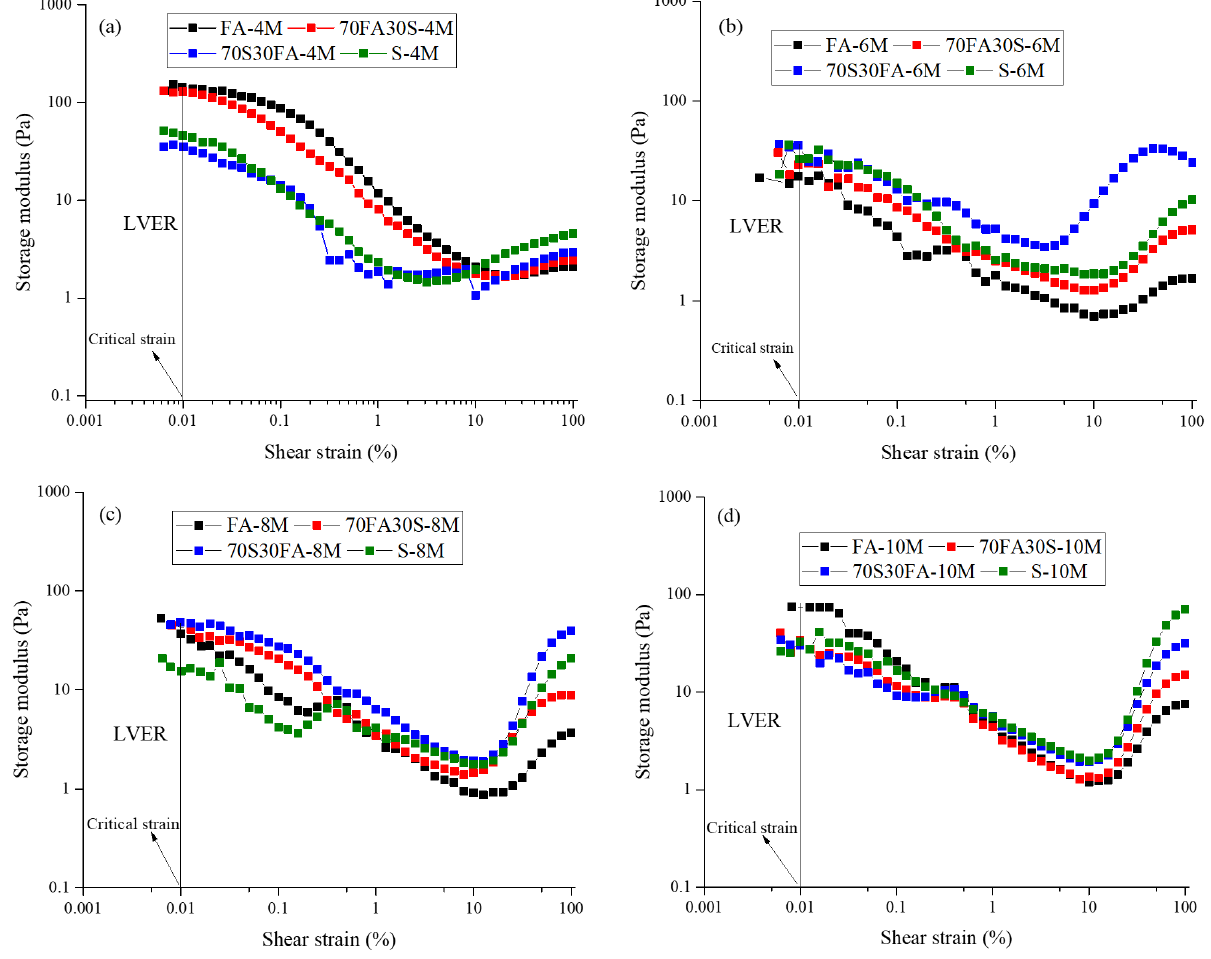
Figure 3. Evolution of storage modulus with the shear strain: NaOH molarity of ( a ) 4 M, ( b ) 6 M, ( c ) 8 M, and ( d ) 10